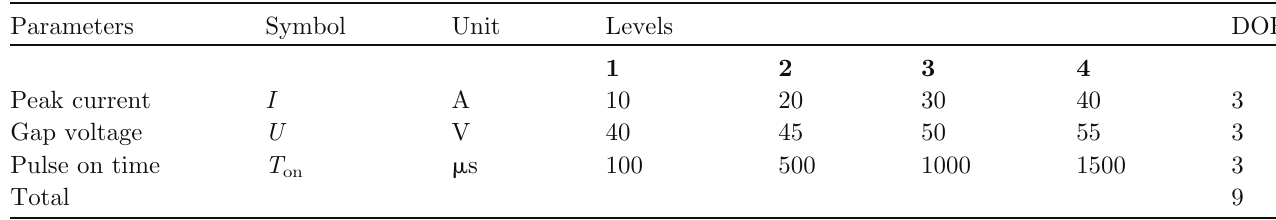
Table 2. Process parameters in the experiment.